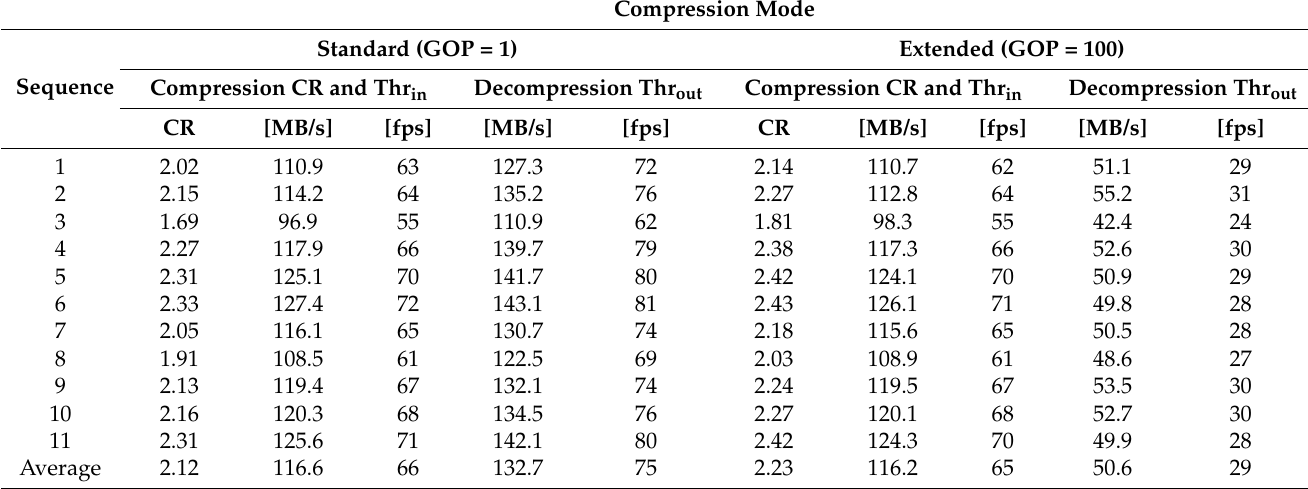
Table 4. Compression ratios and throughputs in the best lossless coding procedure (with separation into R, C1, C2C3 com- ponents) for various video HDR RCCC sequences and compression